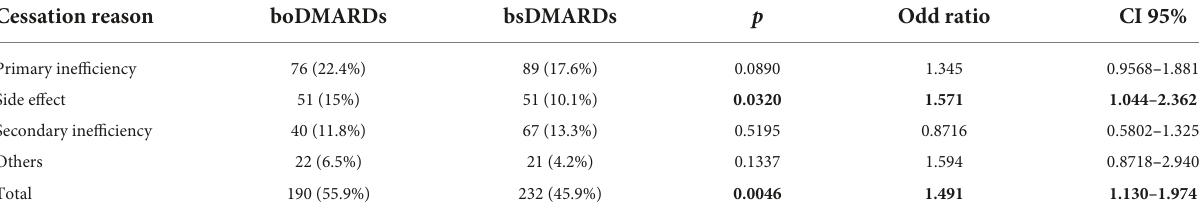
TABLE 5 Reasons for the cessation of